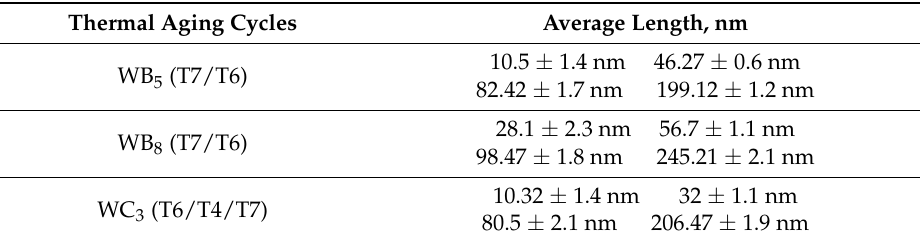
Table 2. Average length of the Mg 2 Si precipitates of A357-SSM